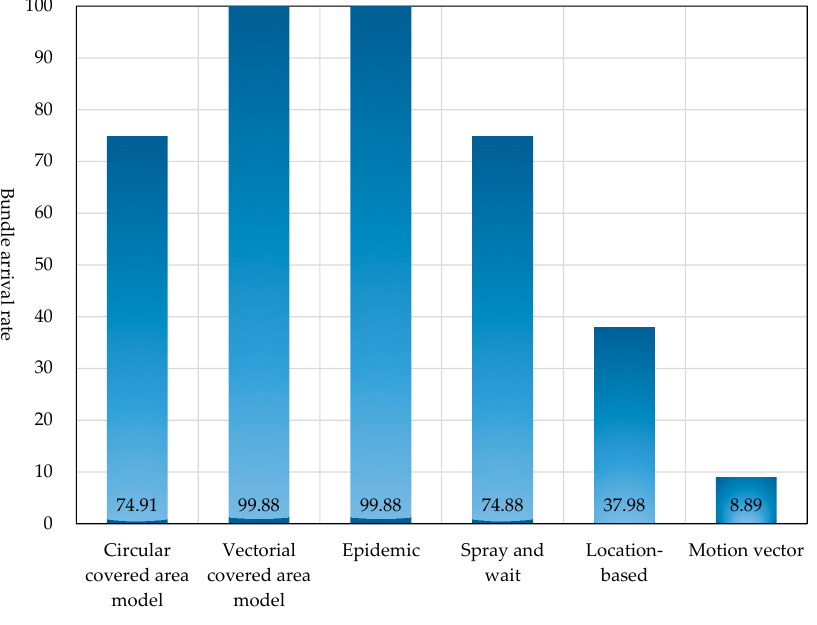
Figure 22. Bundle arrival rate.